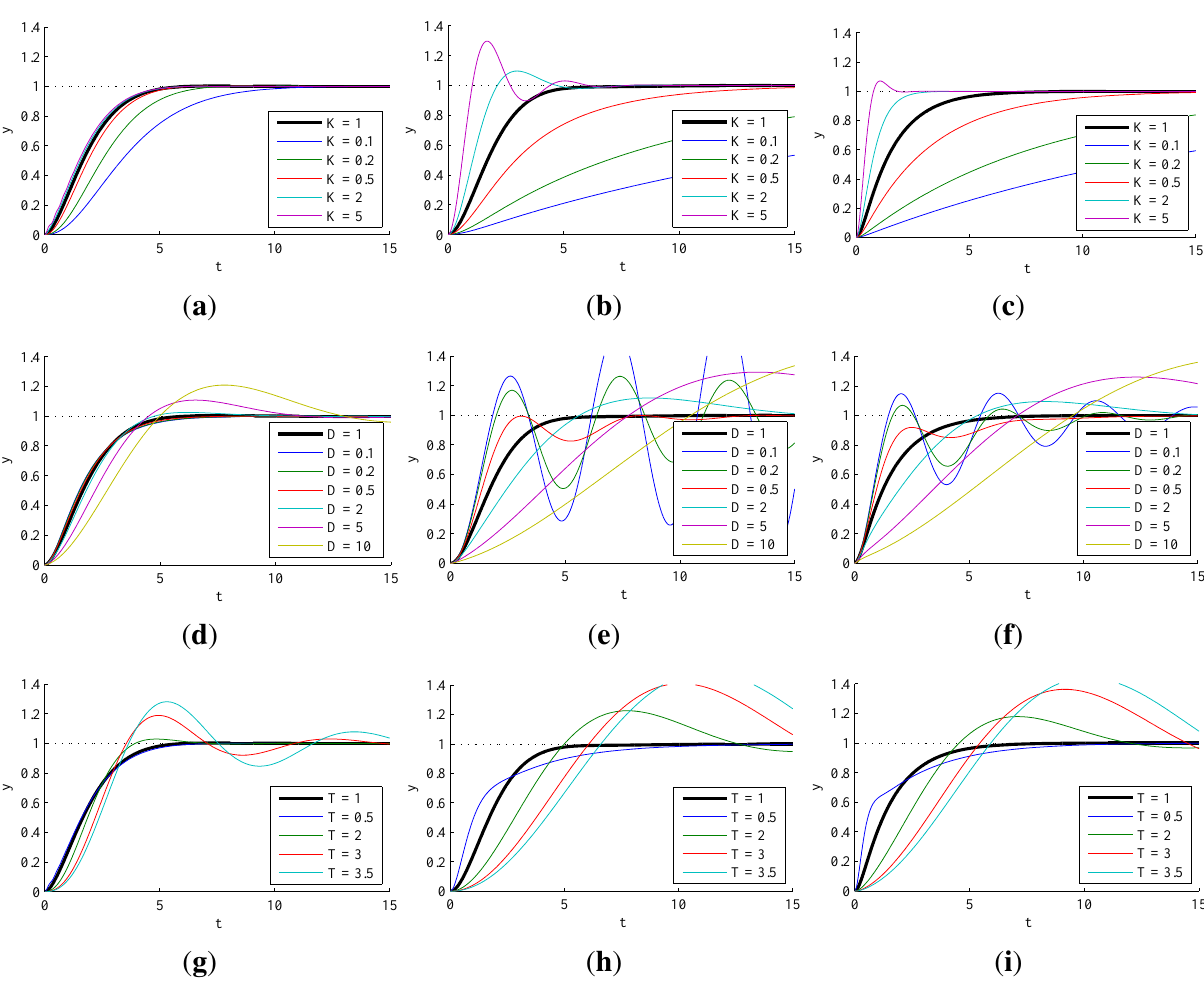
Figure 16. Experiment 3.2.6: comparison of second-order ADRC, PI and PID controllers faced with varying process parameters, K , D and T . Nominal process and ADRC parameters are as throughout Section 3.2. For each combination, the closed loop step response is shown. ( a ) Variation of K , ADRC; ( b ) Variation of K , PI; ( c ) Variation of K , PID; ( d ) Variation of D , ADRC; ( e ) Variation of D , PI; ( f ) Variation of D , PID; ( g ) Variation of T , ADRC; ( h ) Variation of T , PI; ( i ) Variation of T ,